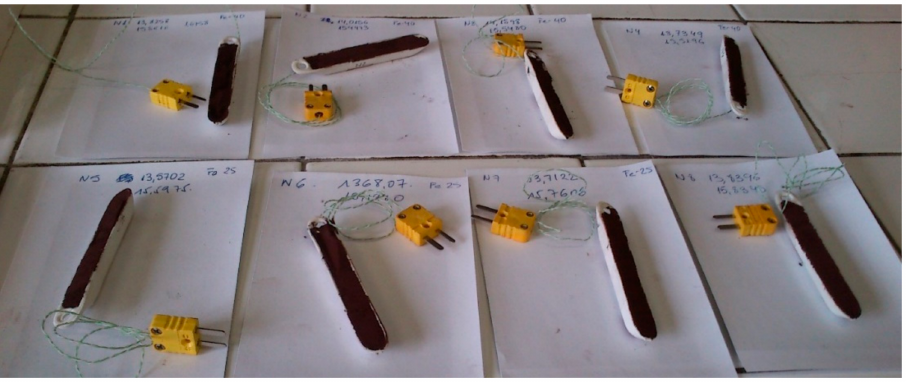
Figure 11. Samples loaded into the